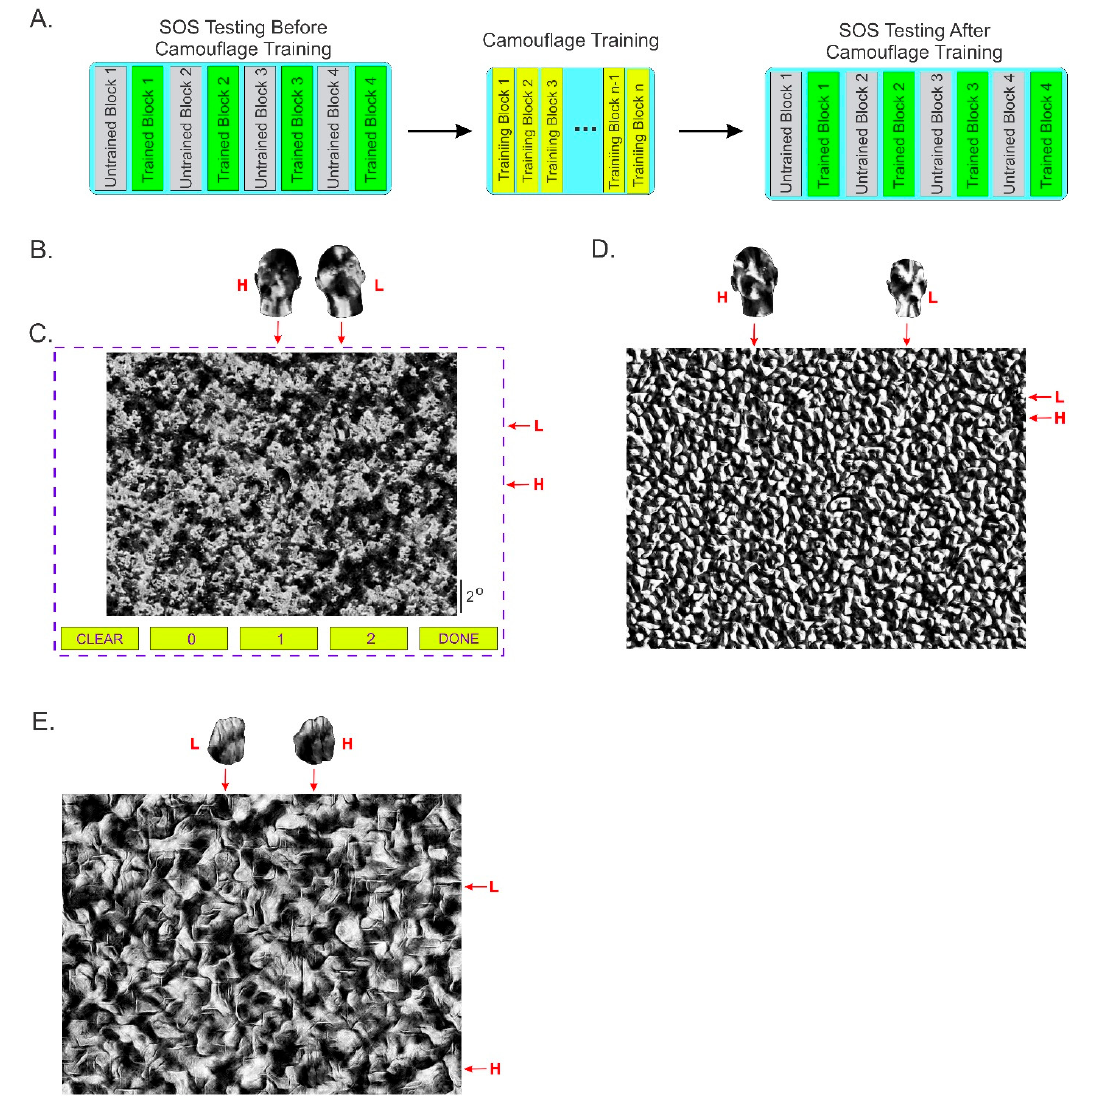
Figure 1. Study design. ( A ) Workflow of Experiment 1. At the start of the experiment, each subject’s baseline SOS was measured for both the designated trained and untrained textures ( far left ). Each subject then underwent as many blocks of camouflage training as necessary for them to reach criterion-level camouflage-breaking performance ( center ). The SOS testing was then repeated ( far right ). The order of the trained vs. untrained blocks was counter-rotated across subjects (not shown). ( B ) Exemplar high-saliency (H) and low-saliency (L) human head targets. For clarity, the targets are shown slightly more magnified than their actual size in the camouflage image. ( left and right , respectively). ( C ) Exemplar SOS test screen with a camouflage image of the texture-type ‘foliage’. The image was of ‘L-and-H’ type in that it contained, in camouflaged form, one H target and one L target that are shown in isolation in panel B. To help the reader detect the targets, the actual horizontal and vertical locations of the targets are denoted by the corresponding red arrows outside the actual screen area ( dashed blue rectangle ). Needless to say, these cues were not available to the subject during the actual experiment. ( D , E ) Additional exemplar images of the L-and-H type, with head targets camouflaged against ‘nuts’ background ( panel D ) and digital embryo targets camouflaged against ‘fruit’ texture ( panel E ). Note that, of the three texture types shown in this figure, only the ‘foliage’ and the ‘fruit’ textures (panels C , E ) were used in Experiment 1. The ‘nuts’ texture shown in panel ( D ) was not used in Experiment 1 (but was used in Experiment 2 below) but is shown in this figure for the sake of comparison. See text for additional